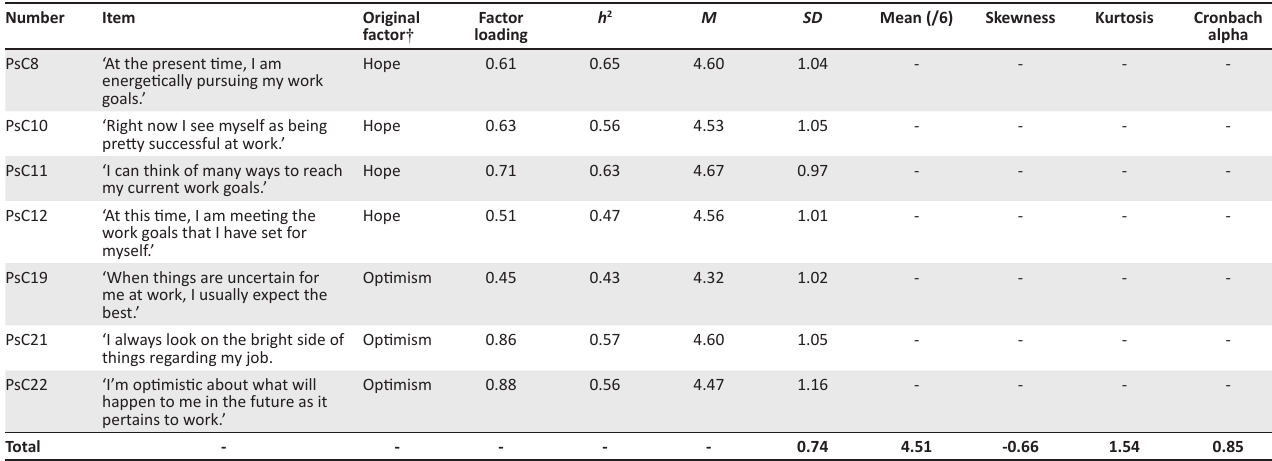
TABLE 9: Factor 2 – Hope & Optimism.